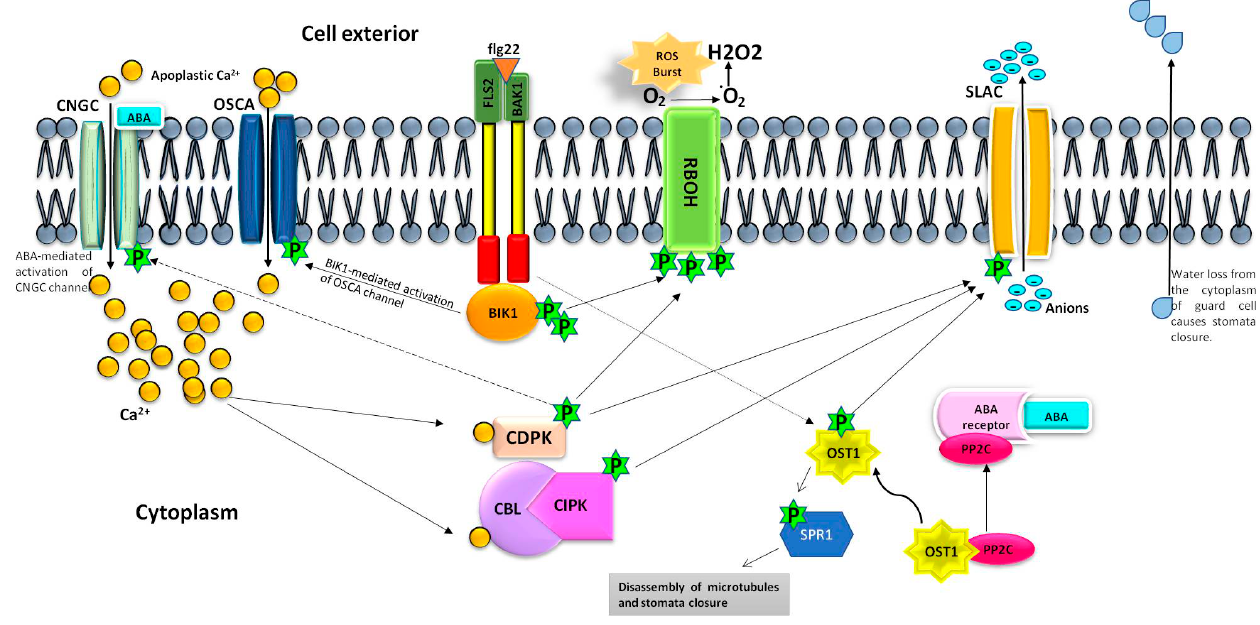
Figure 1. Calcium channels-mediated regulation of stomatal defence. Tan et al. [5] and Thor et al. [6] reveal the identification of Ca 2+ -permeable channels, belonging to cyclic nucleotide-gated channels (CNGCs) and hyperosmolality-gated calcium-permeable channels (OSCAs) associated with stomatal immunity. Abscisic acid (ABA) activates the CNGCs localized in the plasma membrane of guard cells for the influx of Ca 2+ in the cytoplasm that leads to Ca 2+ -dependent stomatal closure by activating the S-type anion channel (SLAC1) [5]. However, the mechanism of ABA-CNGC interaction is still not known. In addition, ABA also releases OPEN STOMATA1 (OST1) from TYPE-2C protein-phosphatases (PP2C) after forming the ‘ABA-ABA receptor-PP2C complex’. The OST1 undergoes either autophosphorylation or transphosphorylation by BAK1 and directly activates SLAC1 that leads to the Ca 2+ -independent stomatal closure [3,9,15,17]. Further, Wang et al. [7] recently described OST1-mediated phosphorylation and dissociation of MAP SPIRAL1 (SPR1) from microtubules, thereby causing the disassembly of microtubules that leads to stomata closure during ABA-mediated stomatal immunity. Thor et al. [6] describe the role of OSCA channels (OSCA1.3 and OSCA1.7) in stomatal defence. The recognition of flagellin protein (flg22) by the leucine-rich repeat (LRR) domain